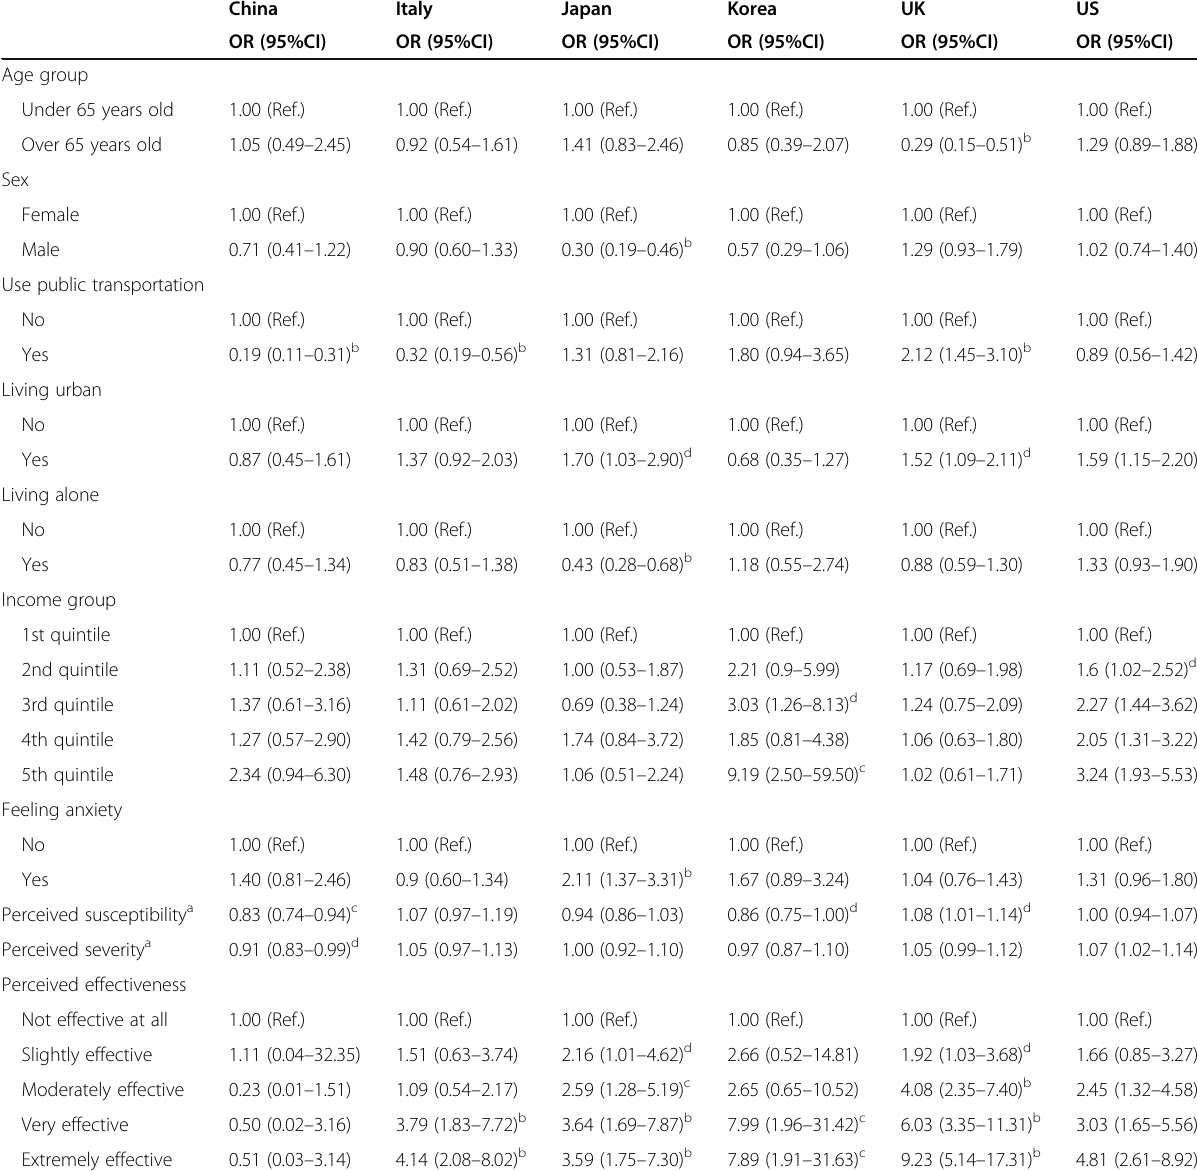
Table 3 Associations between public perceptions, personal characteristics, and wearing a mask